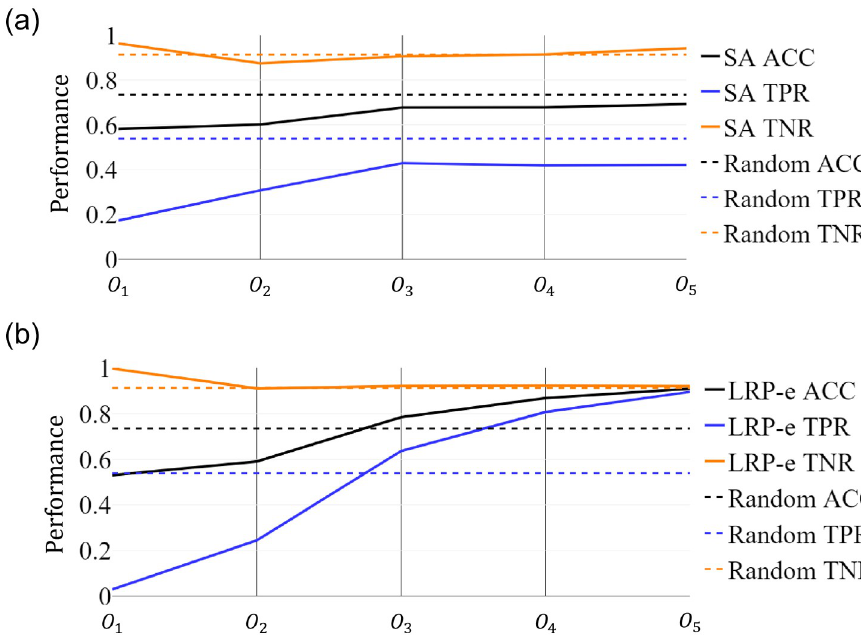
Fig 11. Performance as a function of occluding position O 1 , ��� , O 5 by SA and LRP- � for fixed γ = 2.2, ν = 0.06, τ = − 0.1, and λ = 1.0. (a) SA. (b) LRP- � .